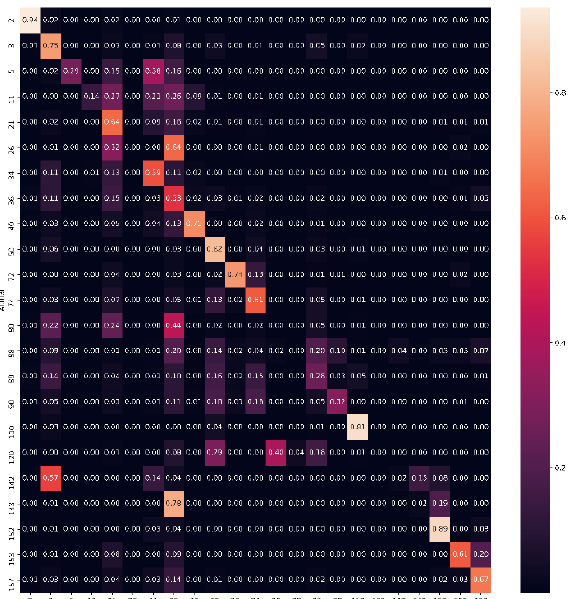
Figure 7 confusion matrix of original sample dataset